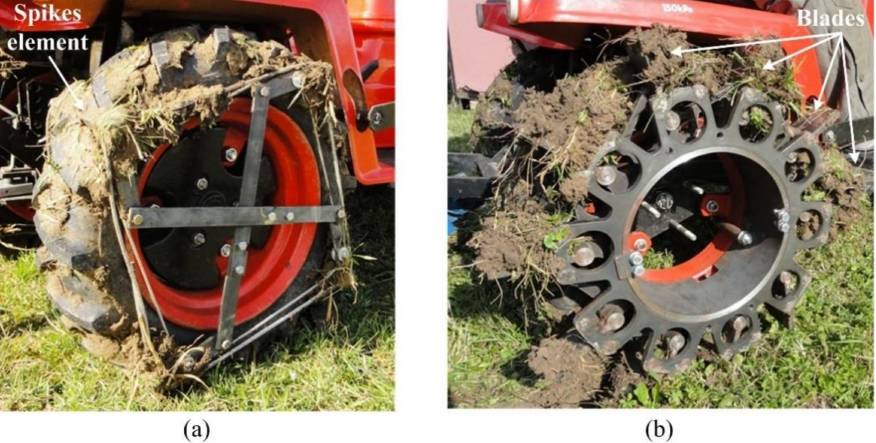
Figure 5. Special driving wheels covered with the soil under operation conditions on the grass plot: ( a ) spike tires; ( b ) blade